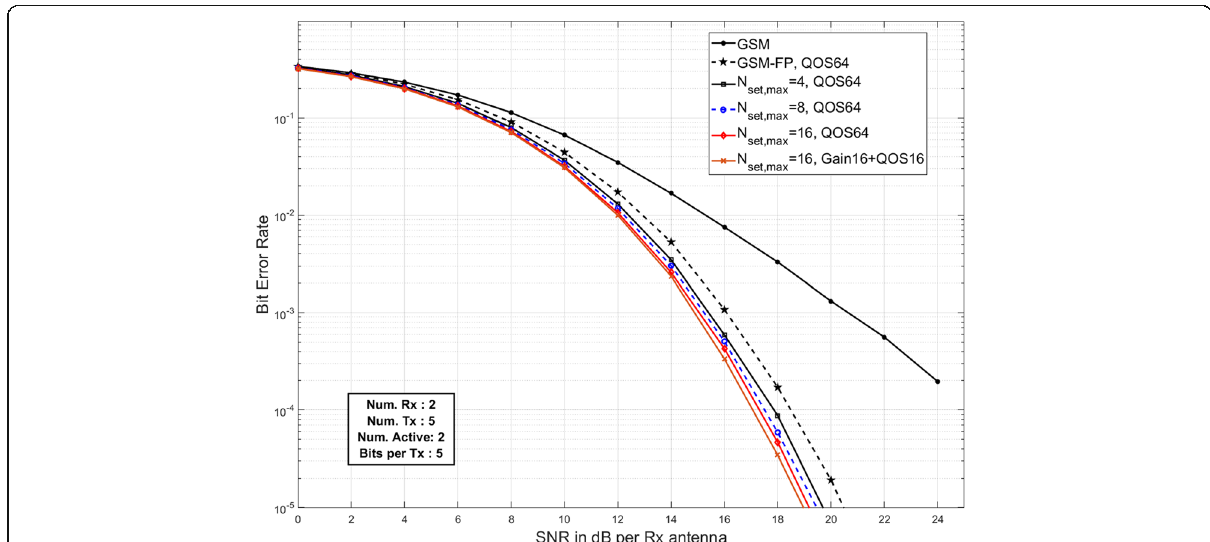
Fig. 8 BER performance of GSM-FP system with codebook precoding and adaptive TAC-set selection at N t = 5, N a = 2, and N r =